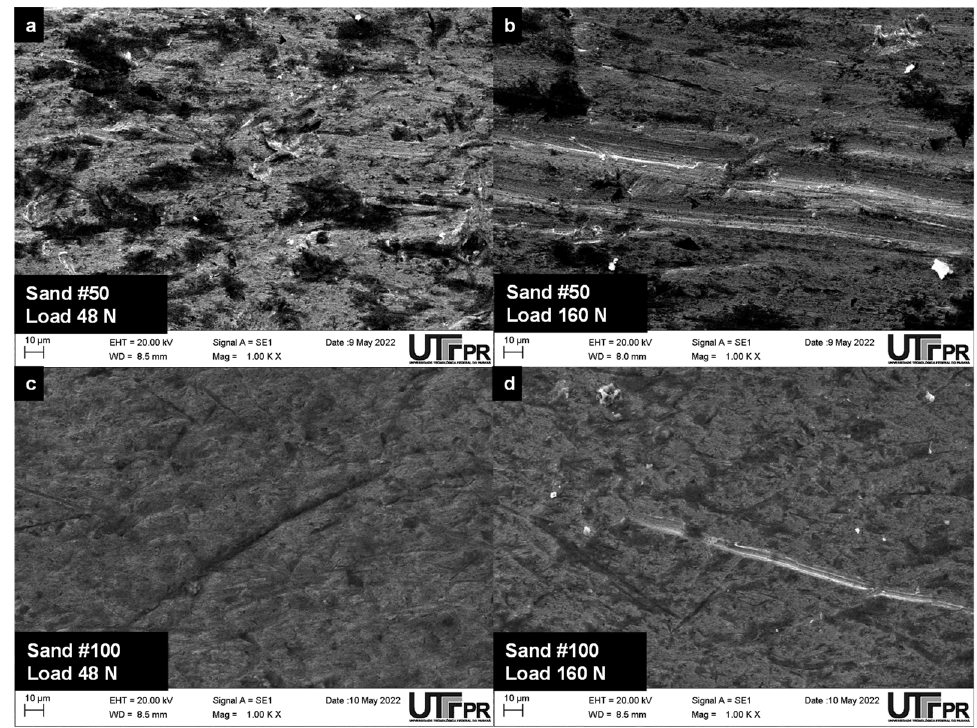
Figure 10. SEM by SEI of Fe-CrC-V coatings (25.4 mm) tested with ( a ) sand #50 load 48 N, ( b ) sand